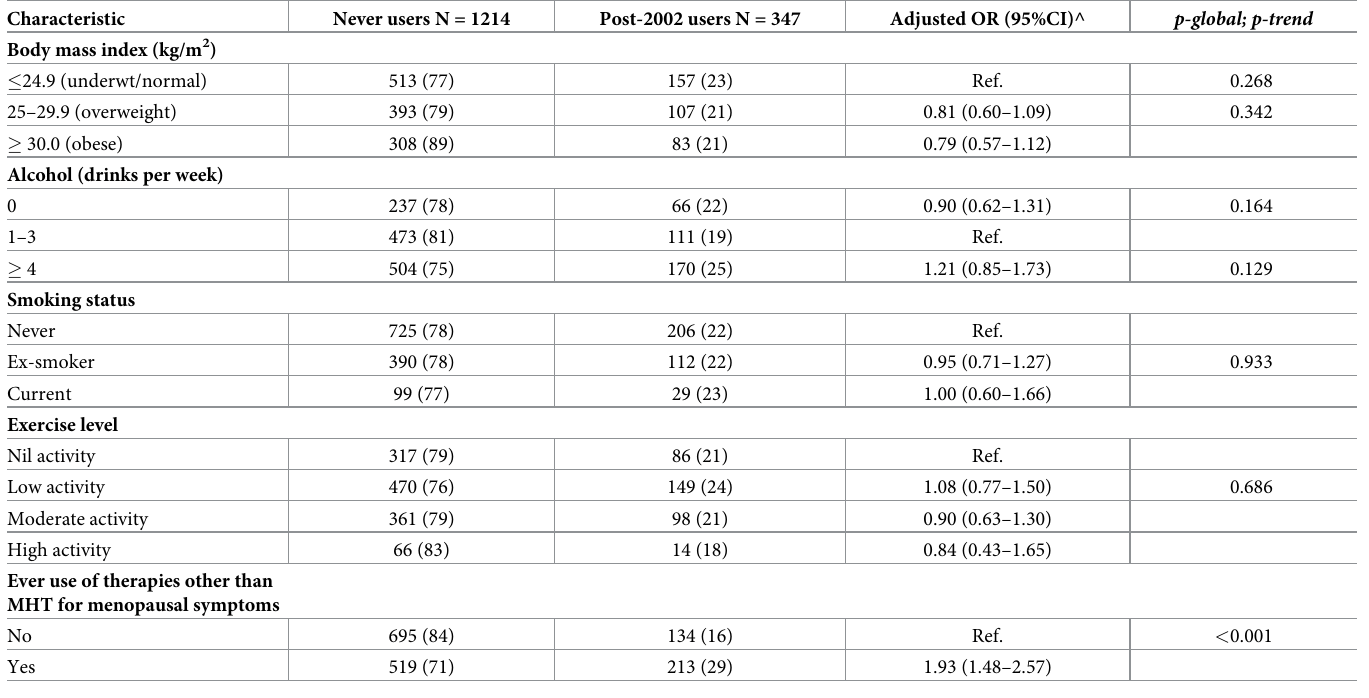
Table 3. Associations of lifestyle behaviours and menopausal hormone therapy use between users initiating MHT after 2002 and never users (younger than 50 in 2002) among Australian women aged 50–69 years